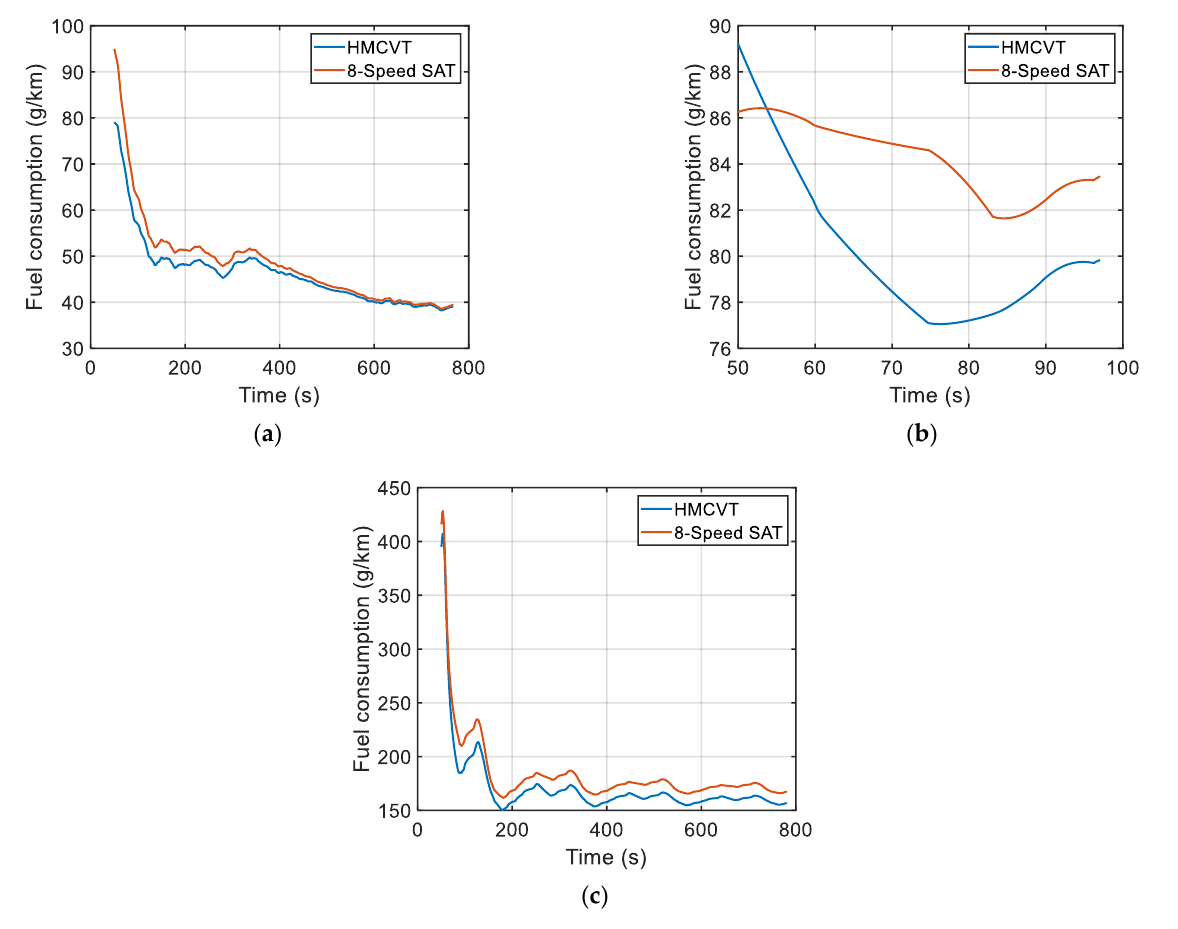
Figure 12. Simulation test results comparison of fuel consumption between HMCVT and 8-speed SAT. ( a ) EPA cycle; ( b ) 6-mode cycle; ( c ) NEDC.